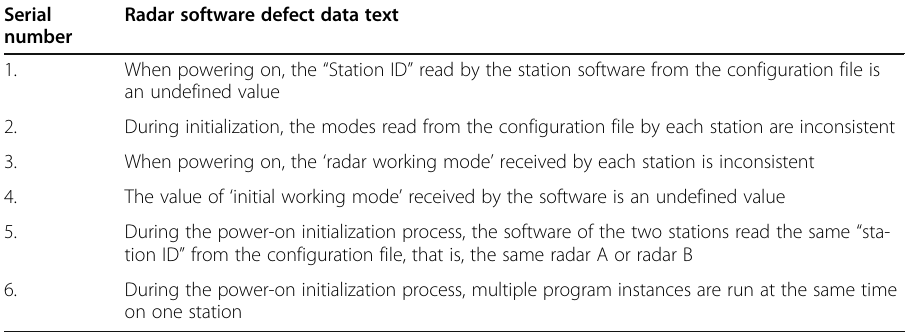
Table 4 Six radar software defects of initialization Serial